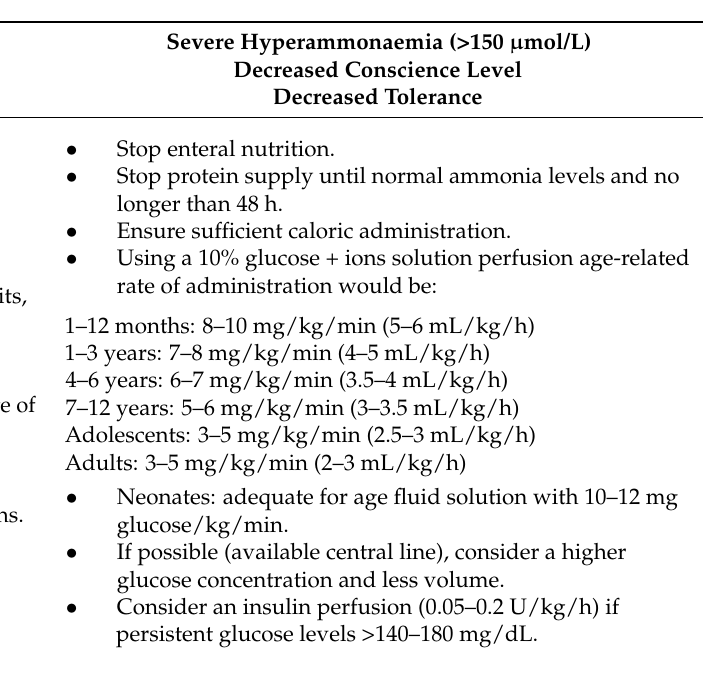
Table 3. Nutritional treatment of acute